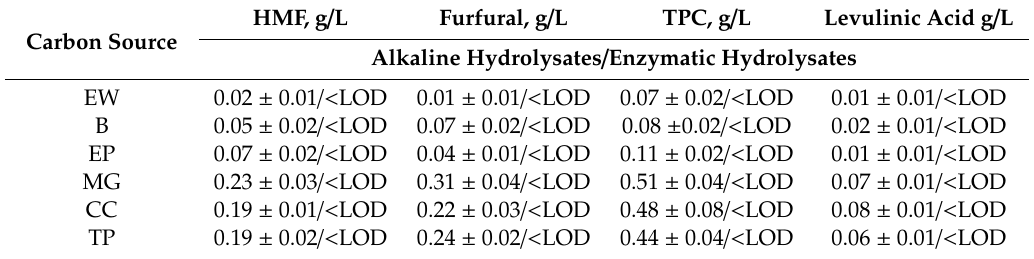
Table 3. Biomass amount recovery after MEA pre-treatment for EW, B, EP, MG, CC and TP. HMF, g / L Furfural, g / L TPC, g / L Levulinic Acid g / L Carbon Source Alkaline Hydrolysates / Enzymatic Hydrolysates EW 0.02 ± 0.01 /<